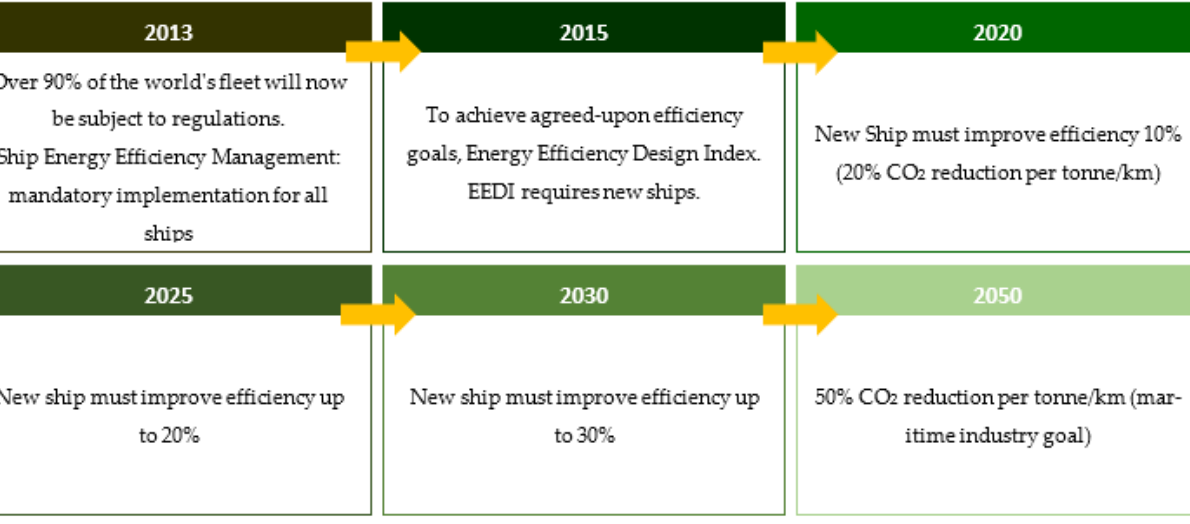
Figure 2. The IMO plan for ship enhancements from 2013 to 2050.